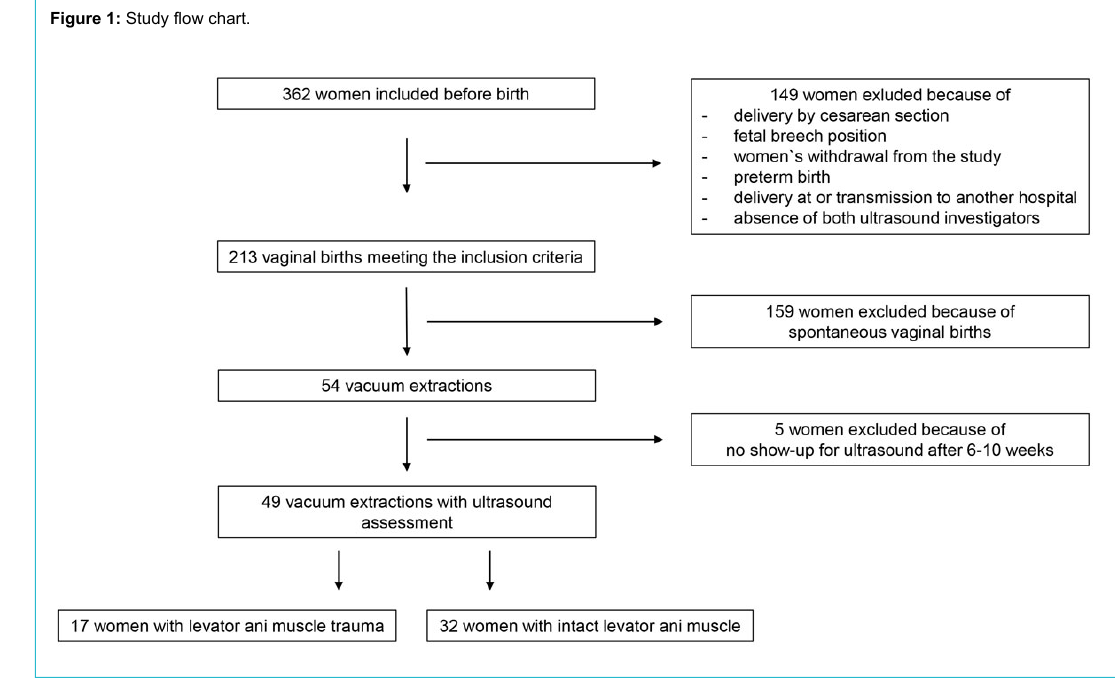
Figure 1: Study flow